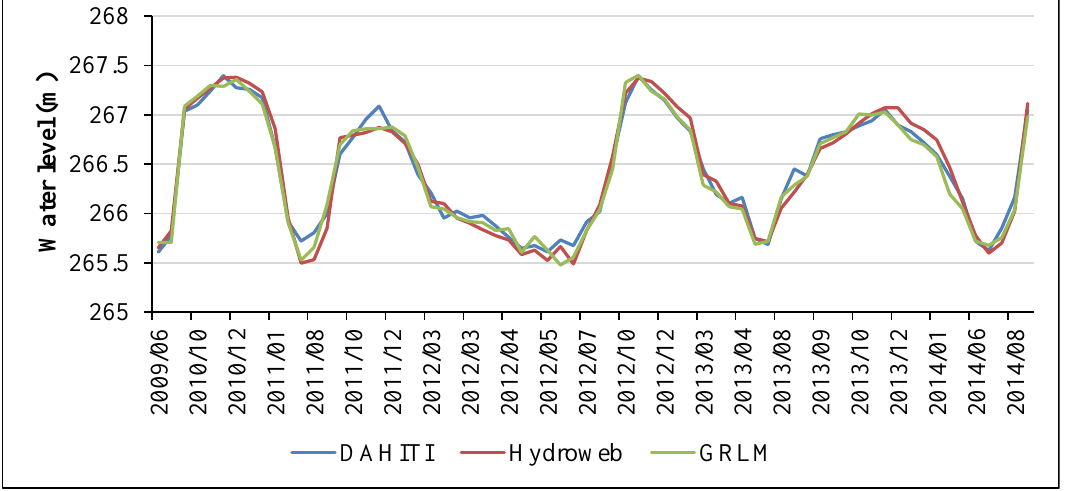
Figure 10. Monthly average water level of the SPLC from 1992 to 2016.